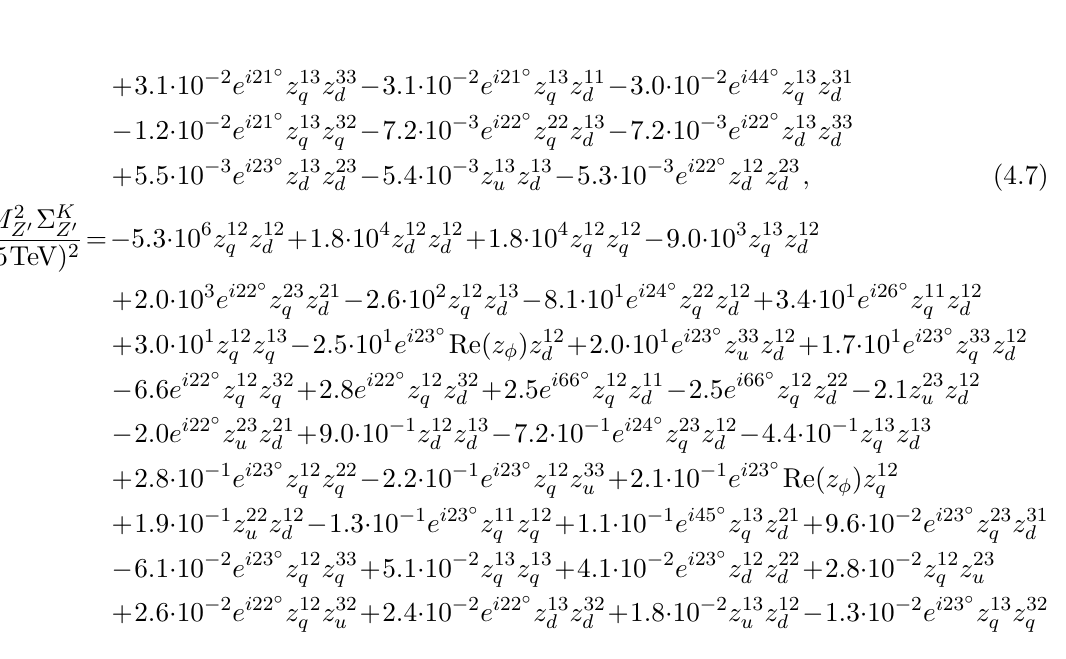
Figure 13 . The maximal NP scale Λ for (cid:2) (cid:3) M ij / (∆ M ij ) exp for B s (blue), B d (red) and K 0 (green), 2 12 BSM